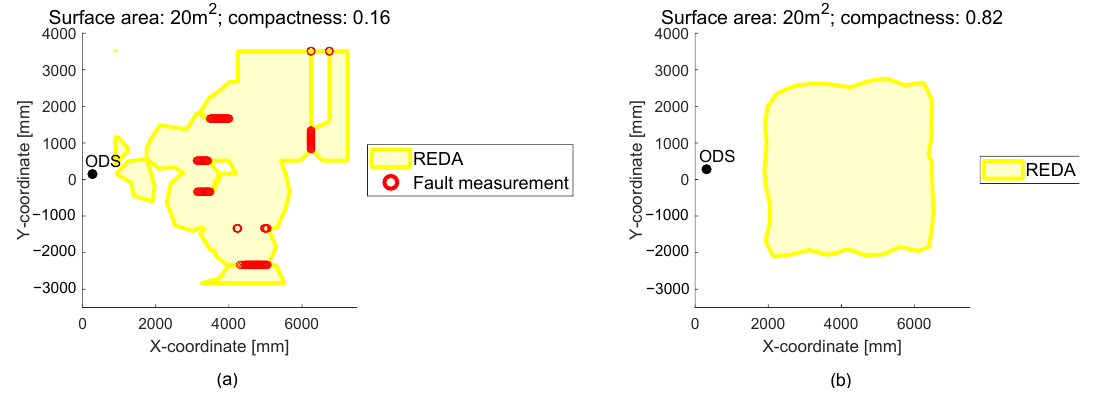
Figure 11. A measured REDA from an ODS with a radar sensor is shown in part ( a ). A measured REDA from an ODS with a stereo camera is shown in part ( b ). Both have a surface area of 20 m 2 . Due to the difference in compactness, these two REDAs can still be